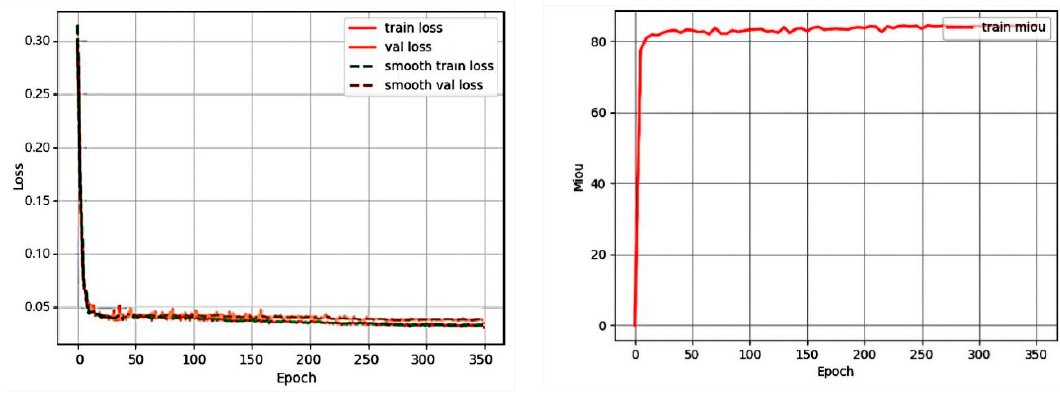
Figure 15. Training curve and MIoU curve of the improved model.